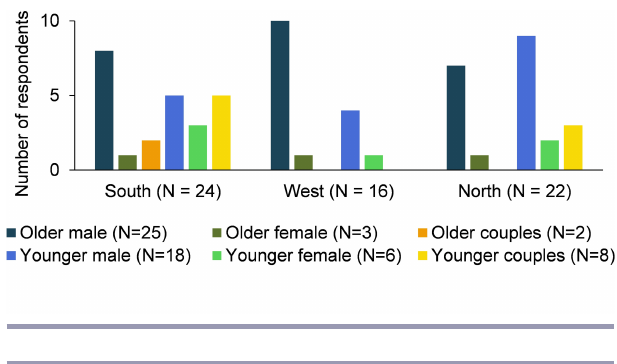
Fig. 2 . Numbers of older and younger (than median birth year